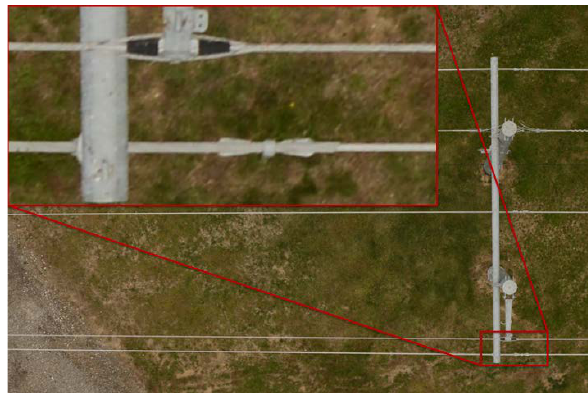
Figure 1. Example of the very high resolution UAS imagery taken over transmission